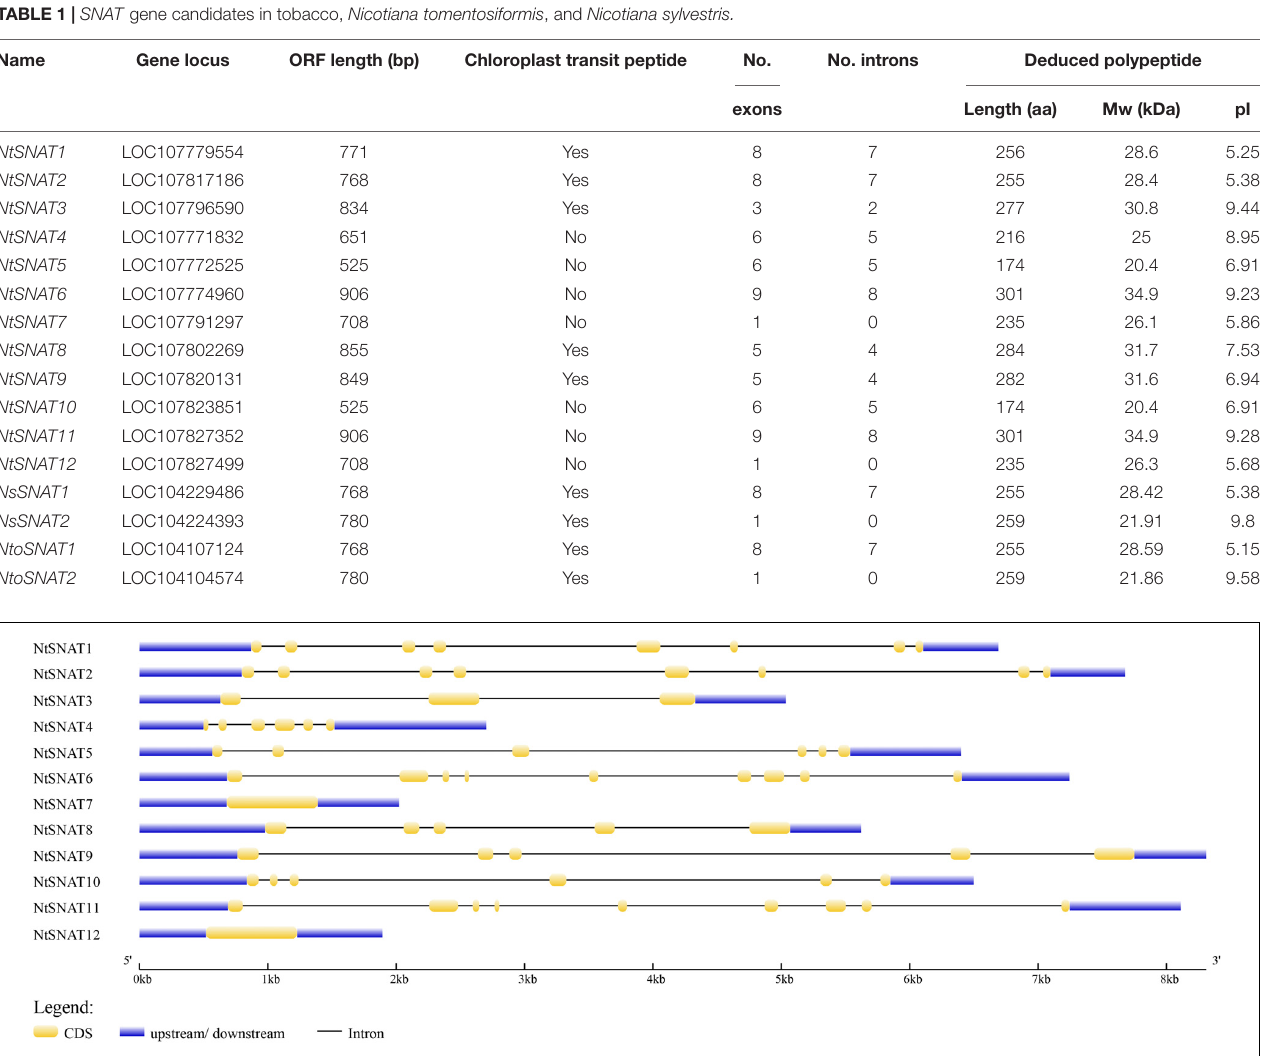
FIGURE 1 | Exon-intron configurations of NtSNAT genes in tobacco plants. The introns and exons are drawn to scale together with the complete coding regions of their respective genes. The boxes indicate the exons, and lines indicate the